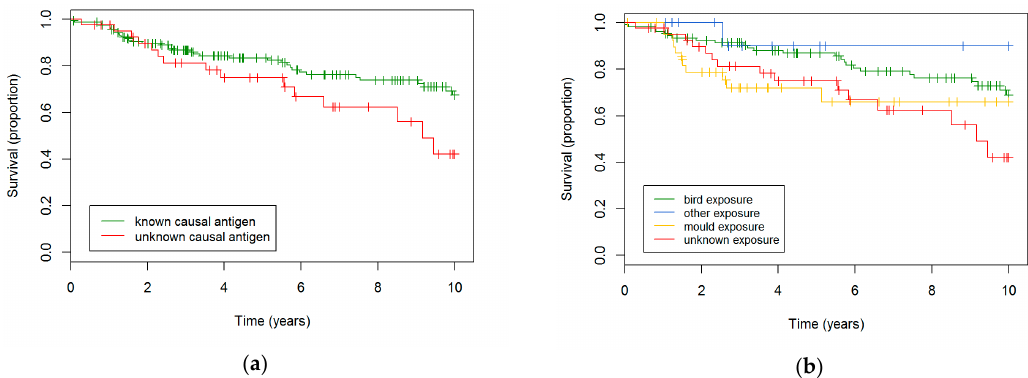
Figure 4. Survival in HP patients according to exposure . ( a ) Survival in HP patients with known and unknown antigen A trend towards worse survival in the patient group with unknown antigen was observed (HR 1.8, p = 0.056), which became statistically significant after multivariate correction